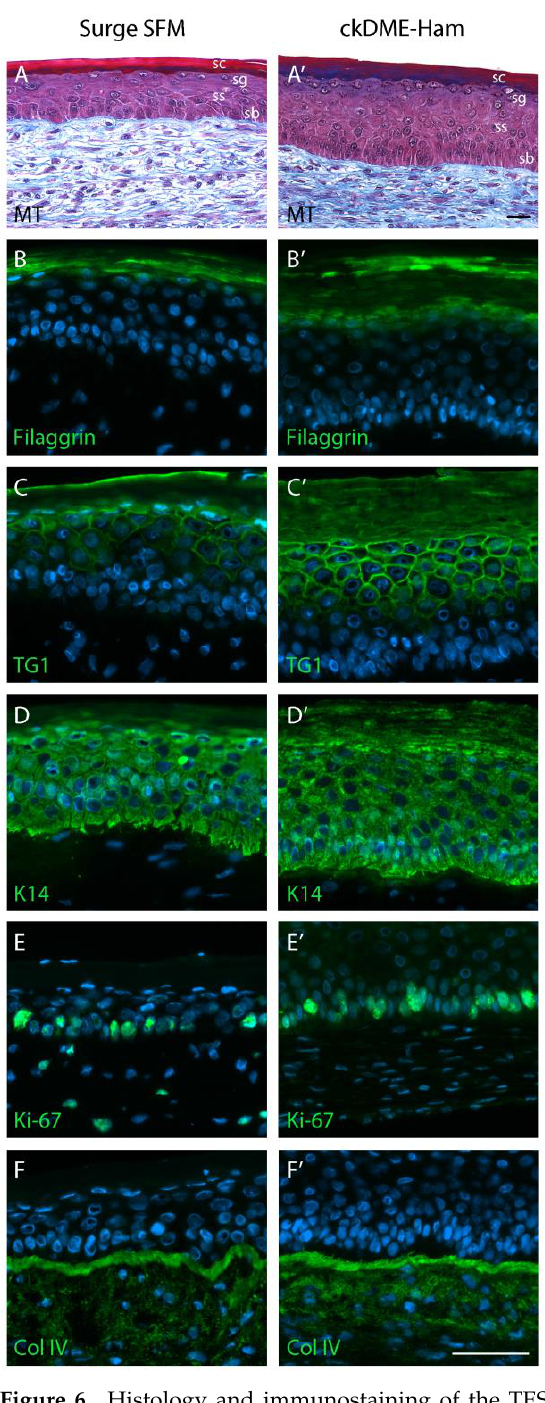
Figure 6. Histology and immunostaining of the TES produced with ( A – F ) Surge SFM or with ( A’ – F’ ) ckDME-Ham. Epidermal layers are identified (sb: stratum basale , ss: stratum spinosum , sg: stratum granulosum , sc: stratum corneum ). ( A , A’ ) Masson’s trichrome staining. Immunofluorescence staining against ( B , B’ ) filaggrin, ( C , C’ ) transglutaminase 1 (TG1), ( D , D’ ) keratin 14 (K14), ( E , E’ ) Ki-67, and ( F , F’ ) type IV collagen (Col IV). Cell nuclei were stained with Hoechst reagent. Scale bars: 50 µ m. 2.6. Self-Assembled Skin Substitutes Produced with Surge SFM Display Long-Term Graft Persistence on Athymic Mice To identify other potential differences between TESs produced with either medium, we then stained against various molecular markers. As expected, the stratum granulosum Lastly, functional studies were performed to evaluate whether the retained epithelial marker filaggrin appeared to be expressed by more cells in TESs made with ckDME-Ham stem cells were sufficient to sustain the epithelial turnover within the neo-epidermis. TESs rather than in those produced with Surge SFM (Figure 6B, B’). In line with this finding and produced with either medium were grafted on athymic mice for up to 26 weeks (6